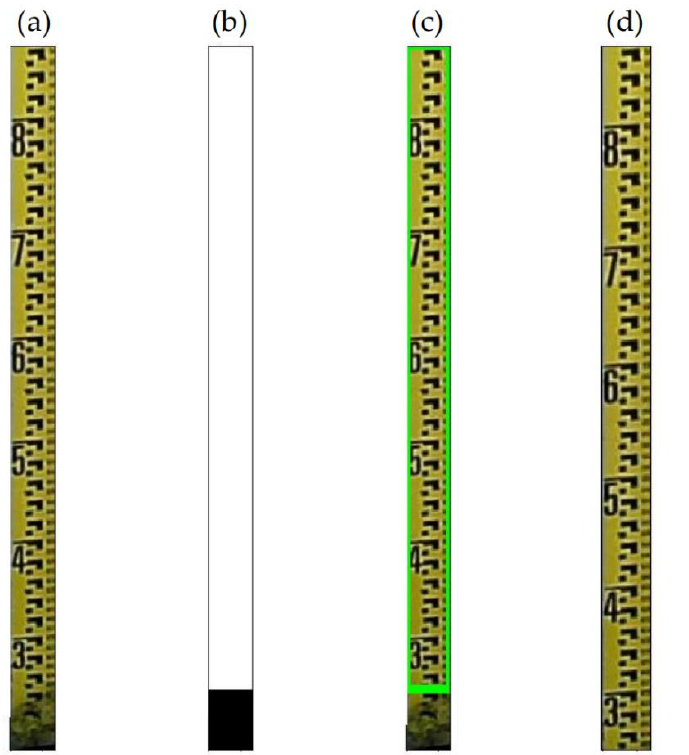
Figure 14. The effect of linear detection and tilt correction. ( a ) The straight line detected by Hough transform from image Figure 13b. ( b ) Rotation correction according to the detected tilt angle (8.3°) of the lines in ( a ). ( c ) The deviation between the displayed value and the real value after tilt correction. After further cropping from Figure 14b, as shown in the processing flow in Figure 15, the part of the water ruler above the water surface is extracted by the closing operation and the function “findContours” in turn.